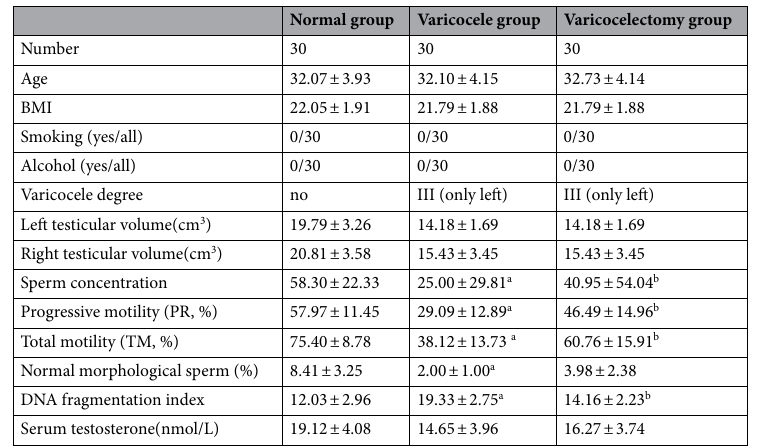
Table 1. Clinical characteristic of the participants. a Compared with the control group, P < 0.05. b compared with the varicocele group, P <